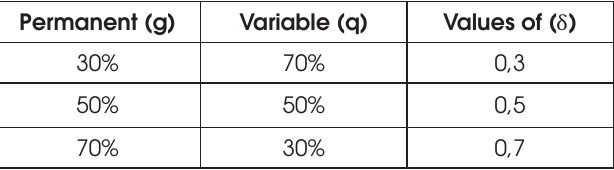
Combinations of considered actions